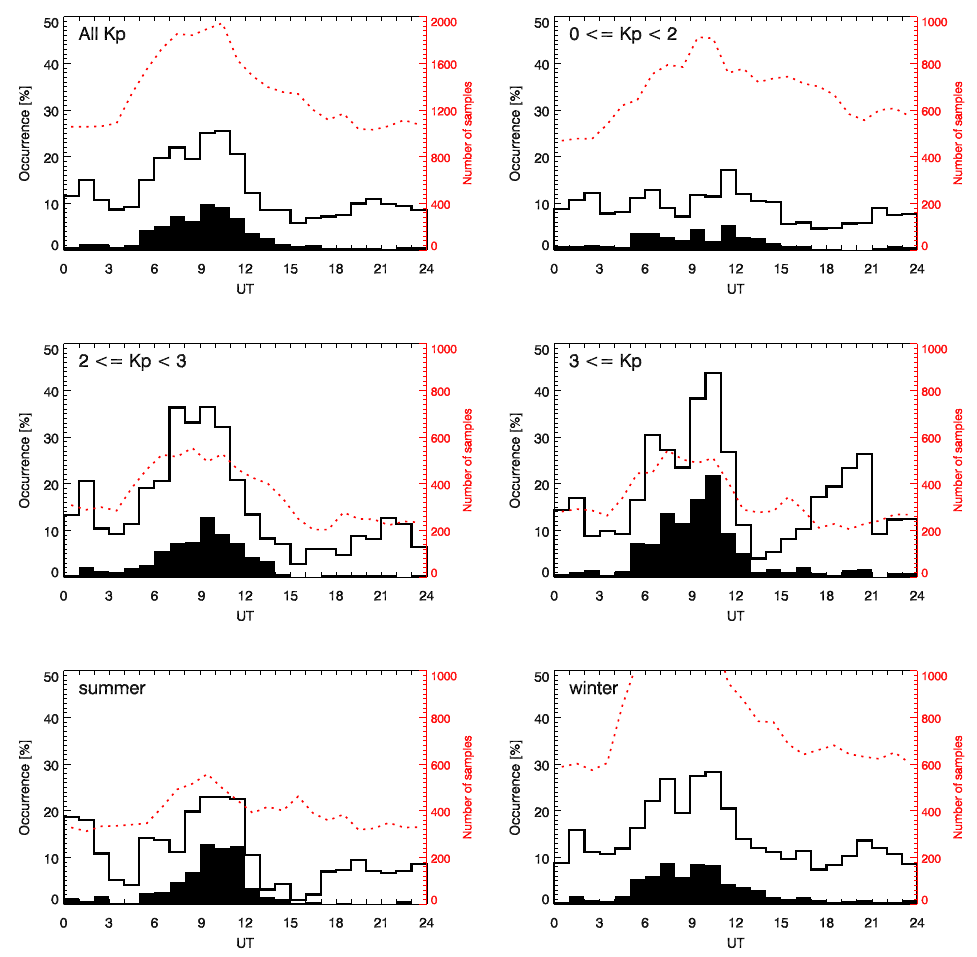
Fig. 8. Histograms of occurrence frequency of up- and downflow overUT for different geomagnetic activity levels according to the K p index and for different seasons. The outlined histogram indicates the occurrence frequency of upflow events and the histogram filled with black indicates how often simultaneously downflow occurred. Also, the number of available velocity profiles is displayed (red dotted lines).